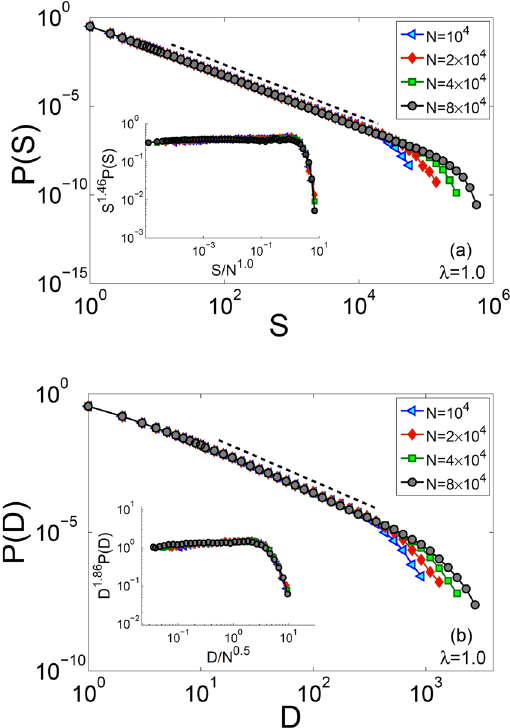
Figure 7. Main panels: probability distribution functions of ( a ) avalanche sizes and ( b ) avalanche durations for systems with λ = 1.0 and different values of N . Inset panel: plots of rescaled data, collapsed into one universal curve with τ S = 1.46, β S = 1.0, τ D = 1.86, and β D =